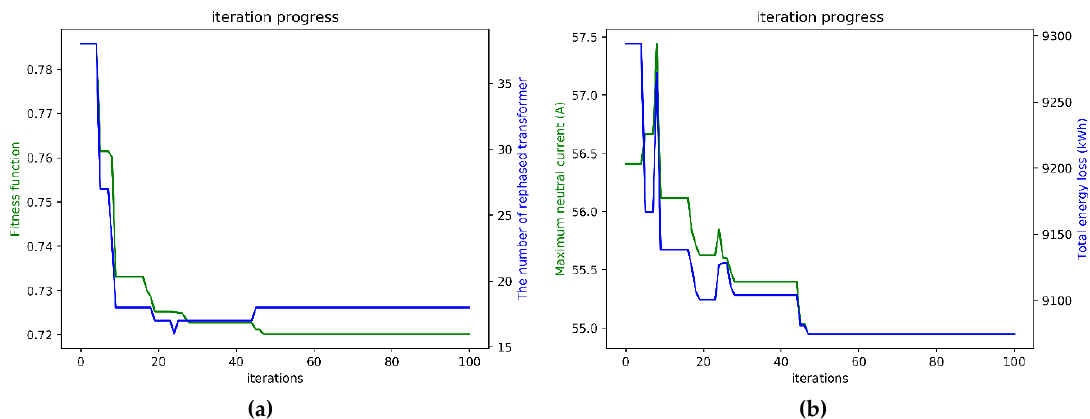
Figure 18. The iterative convergence diagram of Case 2: ( a ) fitness function and rephasing number and ( b ) neutral current and total energy loss. Table 2. Performance comparison of four cases with the original condition.